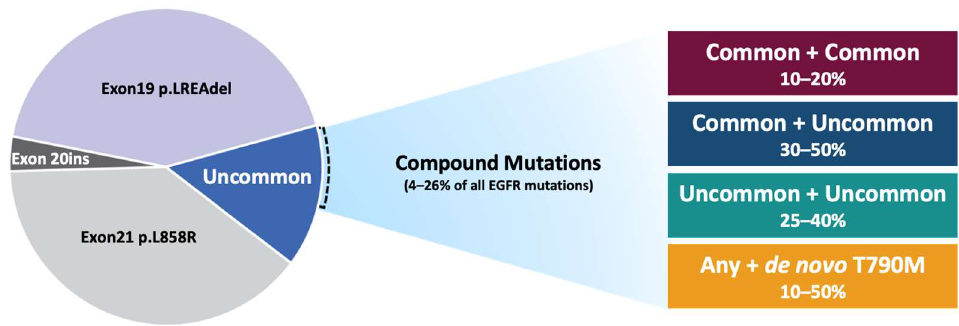
Figure 2. Pie chart representing the EGFR mutation landscape. Compound mutations account for about 4–26% of all EGFR mutations. This heterogeneous group comprises: common + common (e.g., exon 21 p.L858R + exon 19 deletions); common + uncommon (e.g., exon 21 p.L858R + exon 20